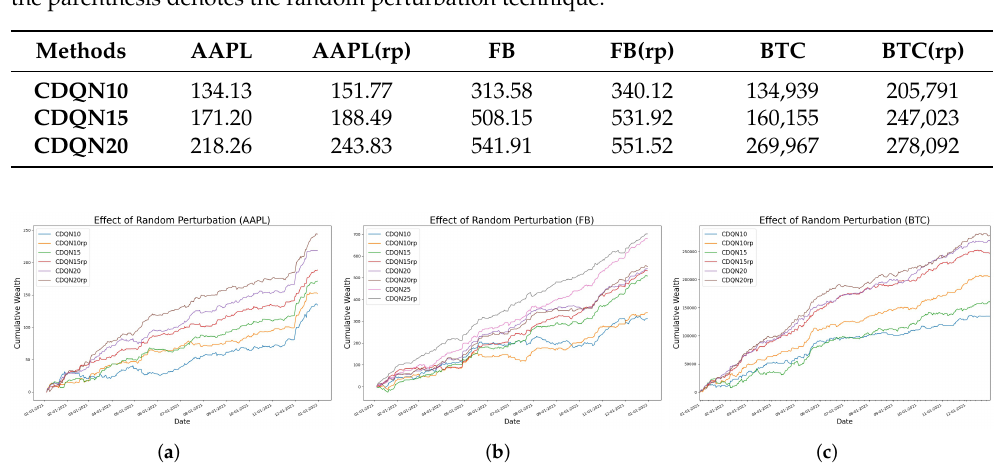
Table 2. Random Perturbation Effect on Cumulative Wealth for Different Datasets. The term “rp” in the parenthesis denotes the random perturbation technique.